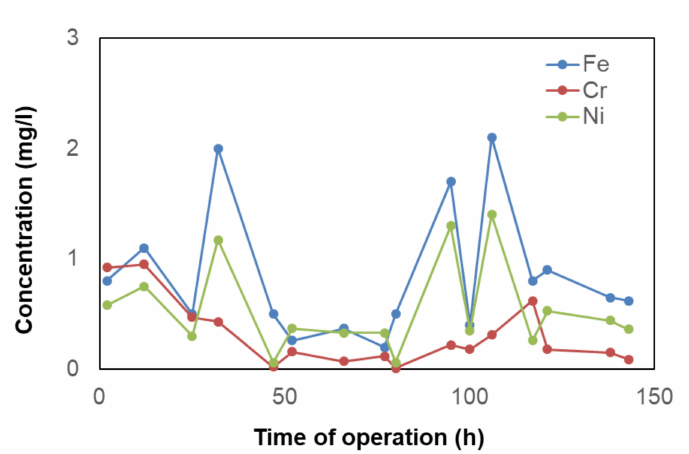
Figure 4. An example of residual concentrations of the contaminants after